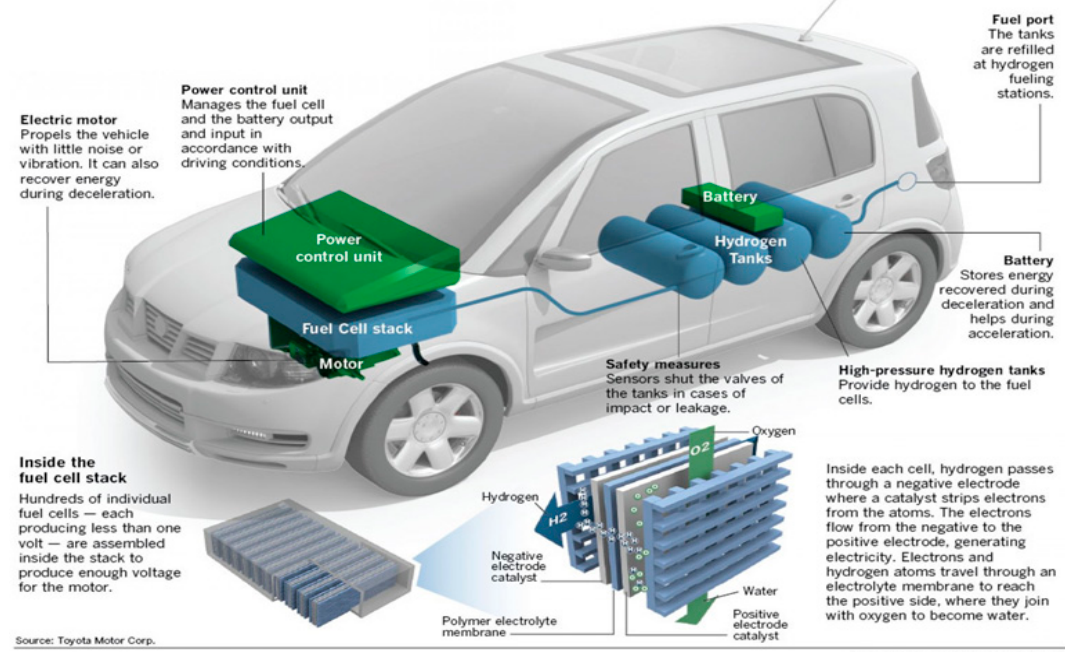
Figure 1. How a fuel cell car works.